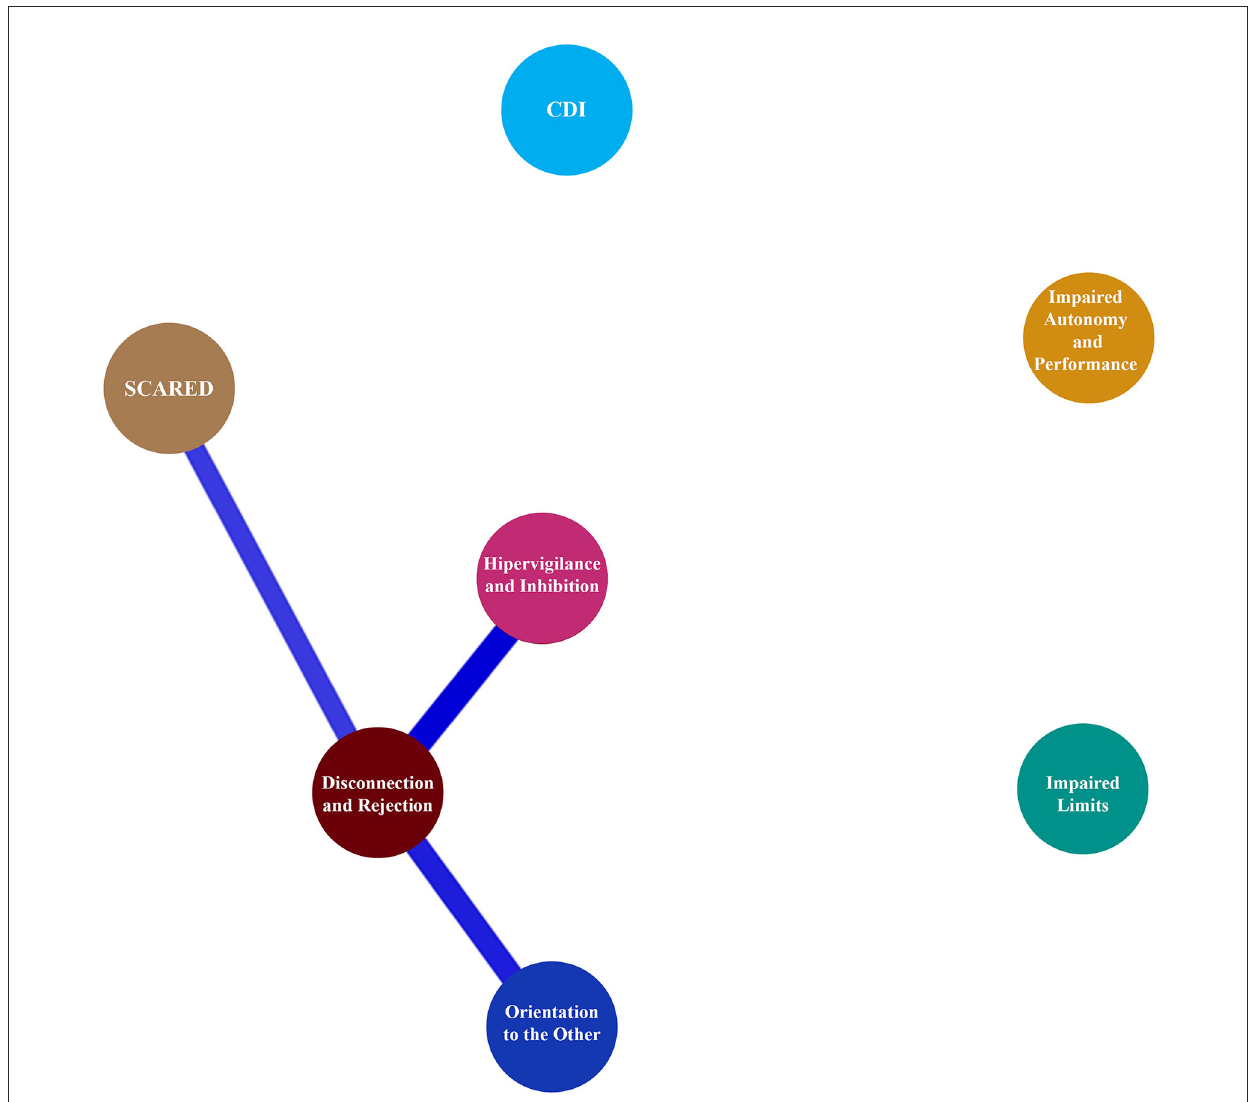
FIGURE4 Network plot for adolescents between CDI, SCARED, and EMS domain with chronic